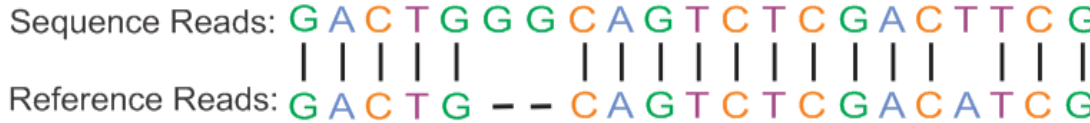
Figure 3. Alignment of target sequence read with reference genome read. The nucleotide of the target sequence read, and a reference sequence is aligned using one-to-one corresponding. The bar sign shows the matched alignment, dashes show the spaces and alignment without bar sign shows the mismatched positions.